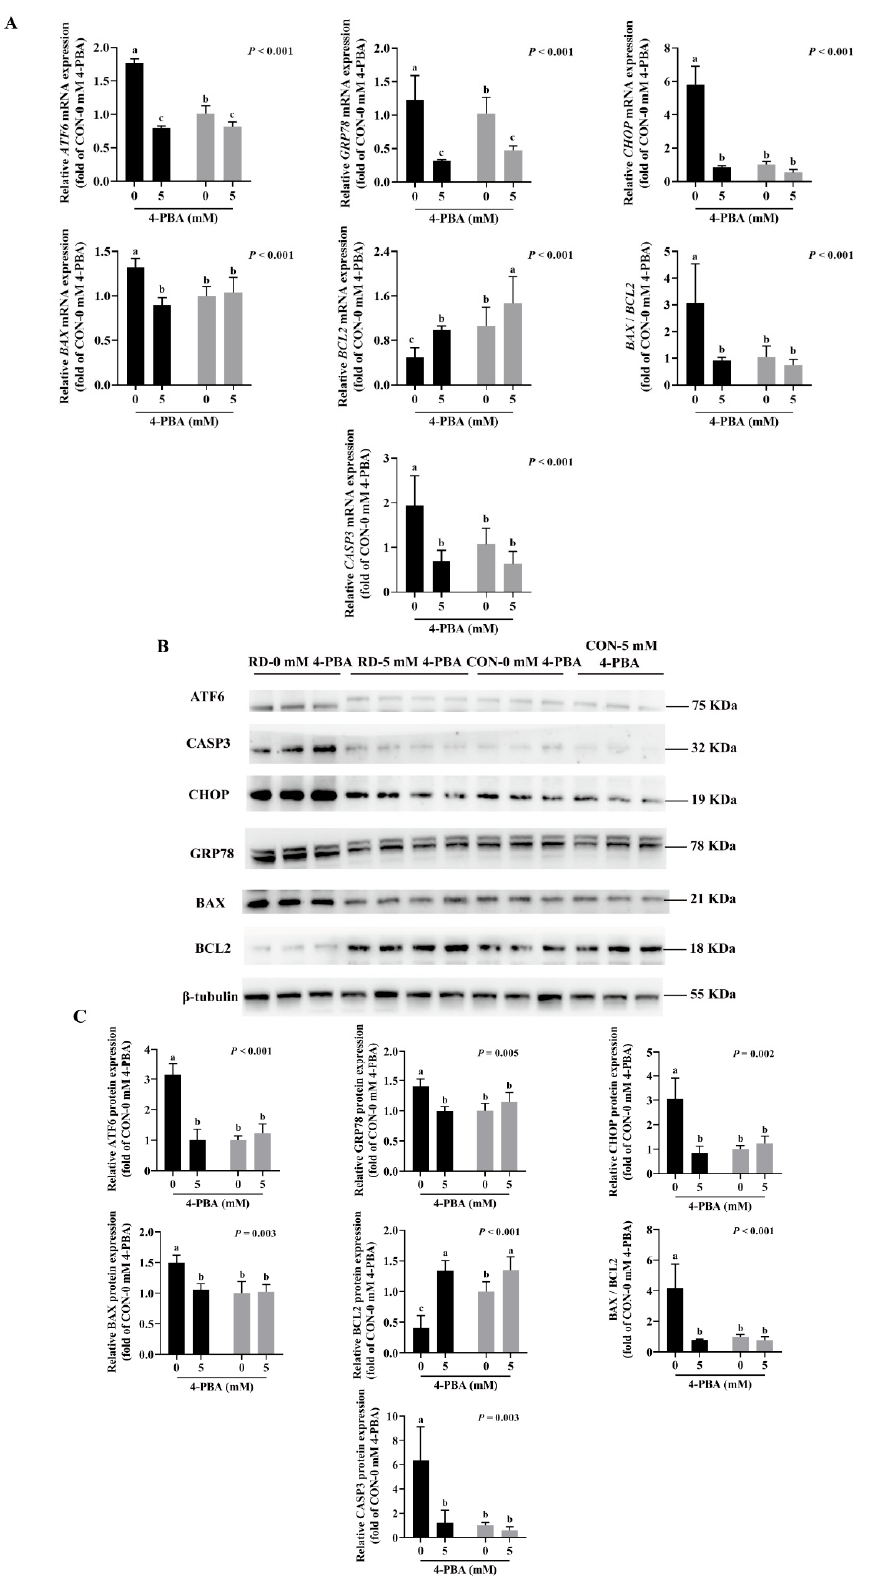
Figure 7. Expression analysis of ER stress- and apoptosis-related genes and proteins in riboflavin- deficient cells treated with 4-PBA. ( A ) Results of 4-PBA treatment on the mRNA expression of riboflavin-deficient cells. Representative real-time PCR of ATF6 , GRP78 , CHOP , BAX , BCL2 , BAX / BCL2